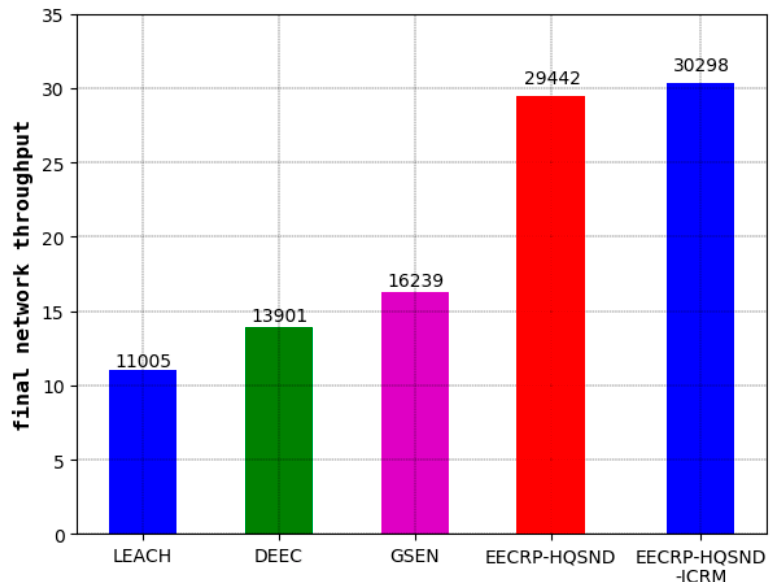
Figure 22. The comparison of the final throughput in the five protocols.